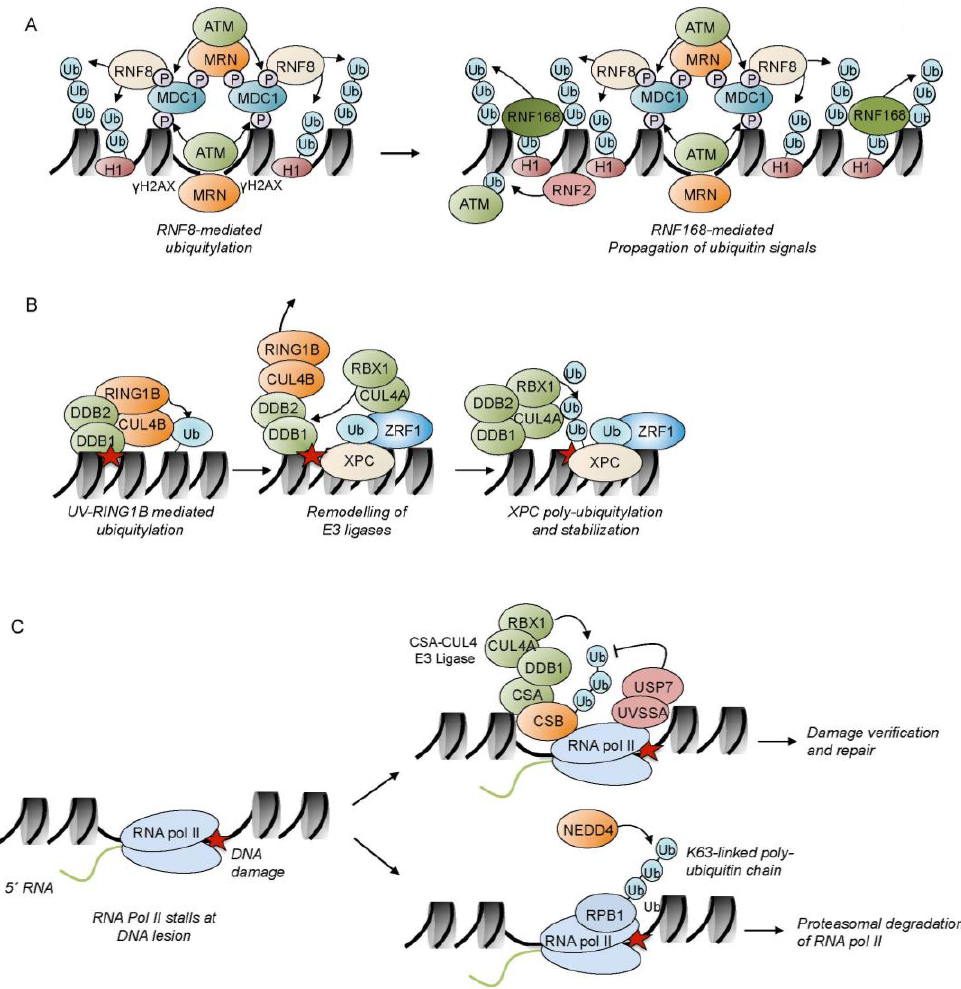
Figure 1. Ubiquitin signaling in both sub-pathways of nucleotide excision repair (NER), global genomic (GG-) and Transcription coupled NER (TC-NER), and double-strand break (DSB) repair. ( A ) Ubiquitin signaling at DSB sites. DSBs are recognized by the MRN (MRE11–RAD50–NBS1) complex, which recruits and activates the ATM kinase through association with its NBS1 subunit. ATM phosphorylates H2AX at S139 ( γ H2AX), thereby generating a binding platform for MDC1 (mediator of DNA damage checkpoint protein 1). The protein Casein kinase 2 (CK2) (not shown for clarity) constitutively phosphorylates residues within MDC1’s SDT domain. Phosphorylated MDC1 is recognized by